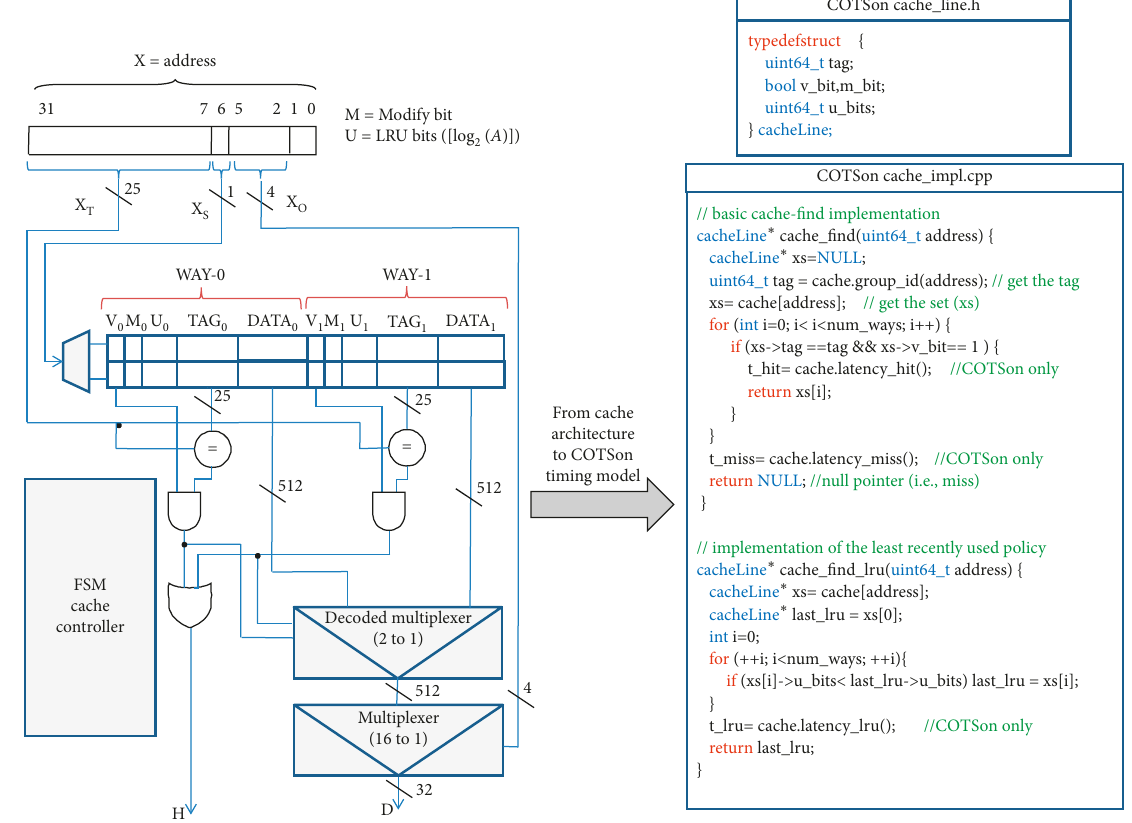
Figure 6: Example of the logic scheme of a two-way set-associative cache. Given the byte address X on 32bits, in this example, the cache indexes four 64-byte blocks (2 words in 2 sets). This implies that the last 6bits are needed to select a byte inside the block: the first 25bits of the address (X T ) are used for tag comparison and the remaining 1bit (X S ) is used for cache set indexing. The cache hit (signal H) is set if the tag of the X is present in the cache at the specified index and if the valid bit is equal to